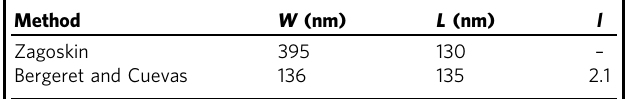
W and L extracted lateral size of SJ1 Josephson coupling.